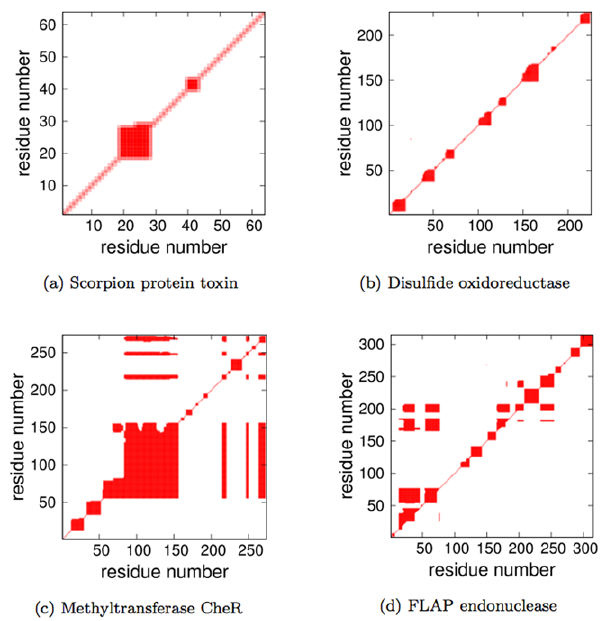
Figure 7. Rigid Cluster Maps (RCM) for four different example proteins near their respective P RM values. PG results are presented in the upper triangle, whereas the VPG is presented in the lower. Note that the presented proteins are the same from Fig. 3a.